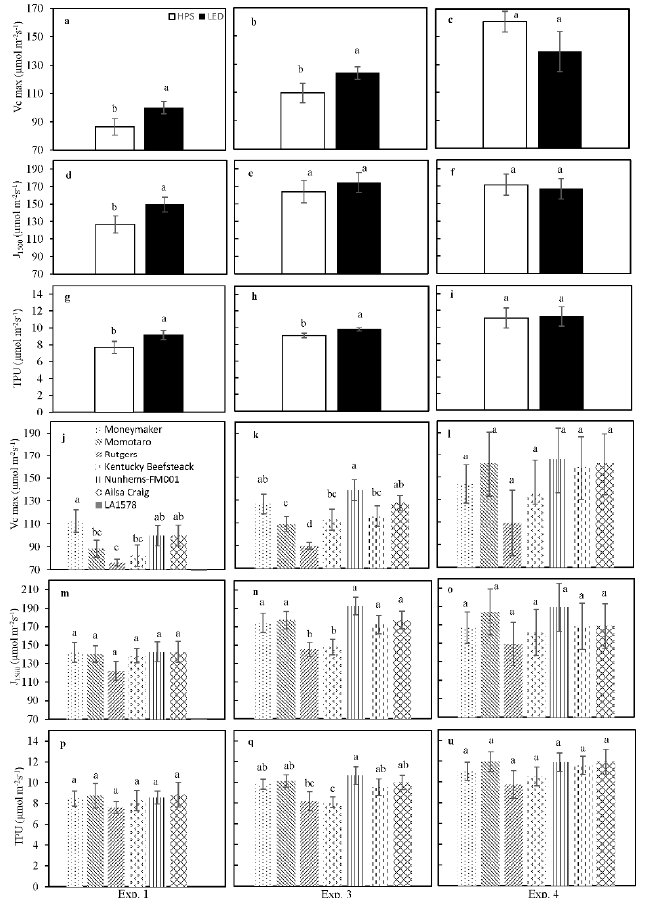
Figure 3. Photosynthetic capacity as affected by supplemental lighting type (HPS or LED) and genotype. V c,max , J 1500 and TPU compared in experiment (Exp.) 1 ( a , d , g , j , m , p ), Exp. 3 ( b , e , h , k , n , q ) and Exp. 4 ( c , f , i , l , o , u ) between the supplemental light conditions (from a to i ) and between genotypes (from j to u ). Different letters on top of a bar within each panel indicate significant differences according to Fisher’s protected LSD test ( p = 0.05). Error bars show ± SE (supplementary light: n = 21; genotypes: n = 3).